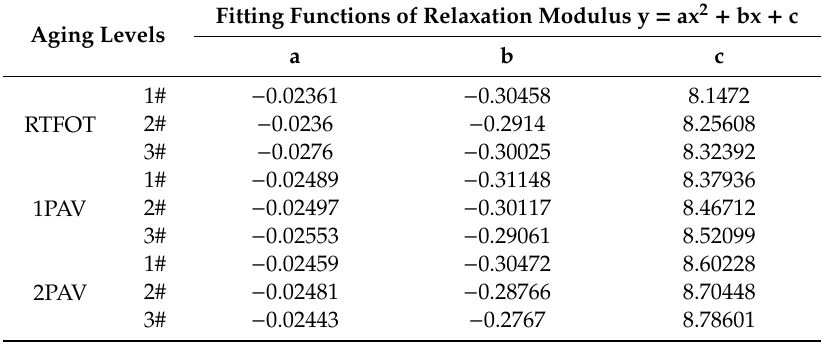
Table 5. Fitting parameters of master curves of relaxation modulus for the three aging levels. Aging Levels